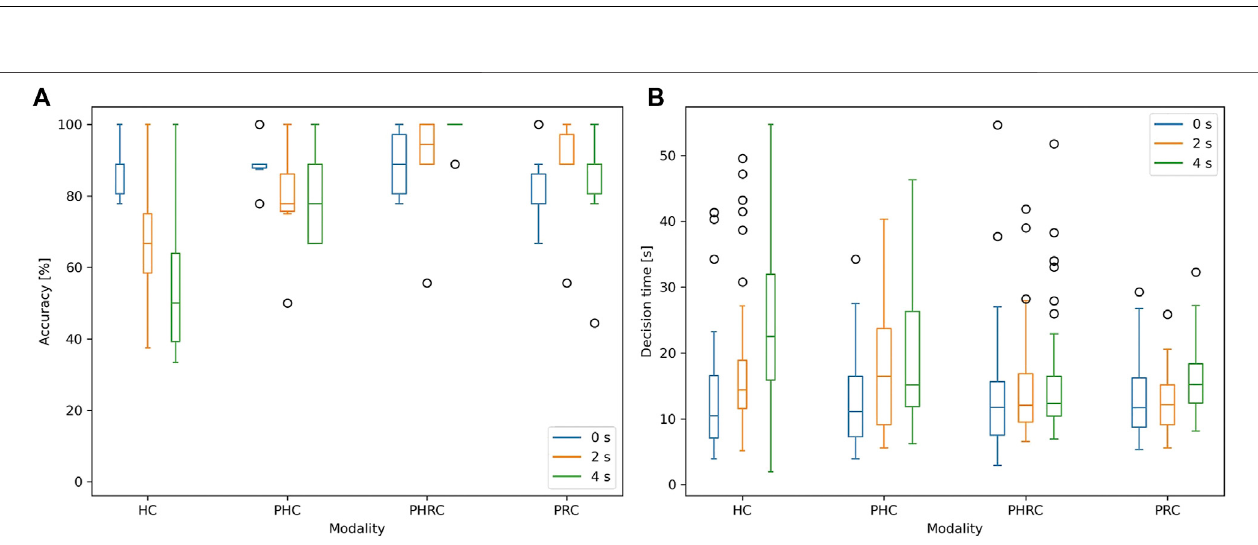
FIGURE 8 | Box plots of accuracy (A) and decision time (B) as a function of the delay introduced, in the four different control modalities. Decision time is the time elapsed from the fi rst contact to the subject ’ s answer.